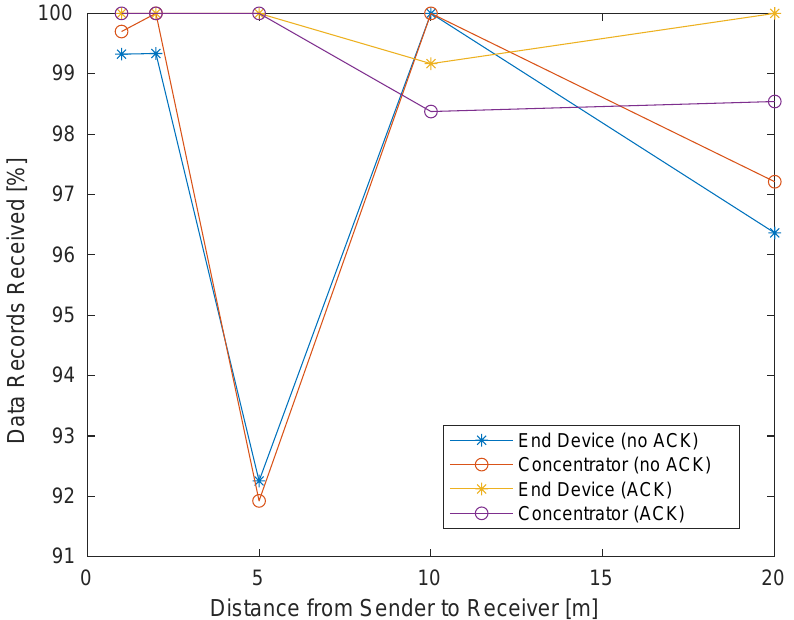
Figure 6. Transmission